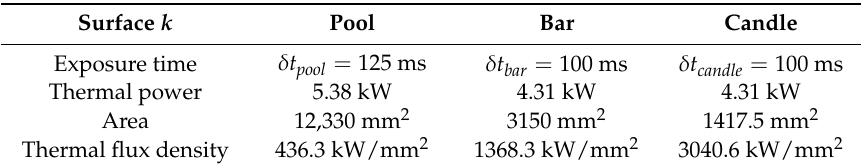
Table 2. Exposuretimeoftheelectronbeamoneachsurface“pool”, “bar”and“candle”, andcorresponding Table 2. Exposure time of the electron beam on each surface “pool”, “bar” and “candle”, and thermal power and flux corresponding thermal power and flux density.